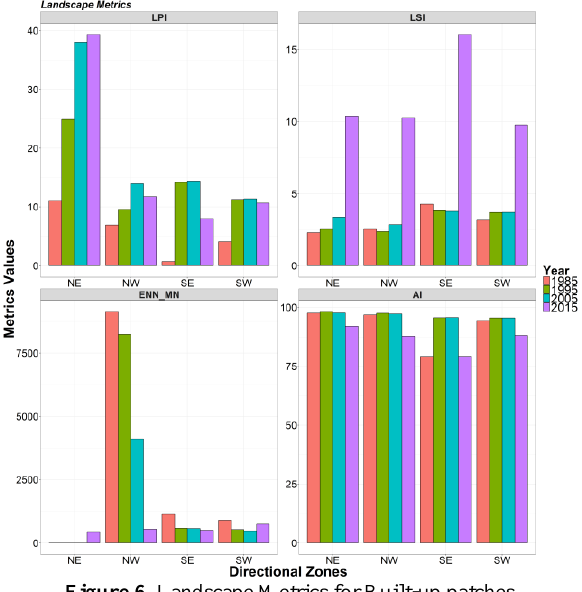
Figure 6. Landscape Metrics for Built-up